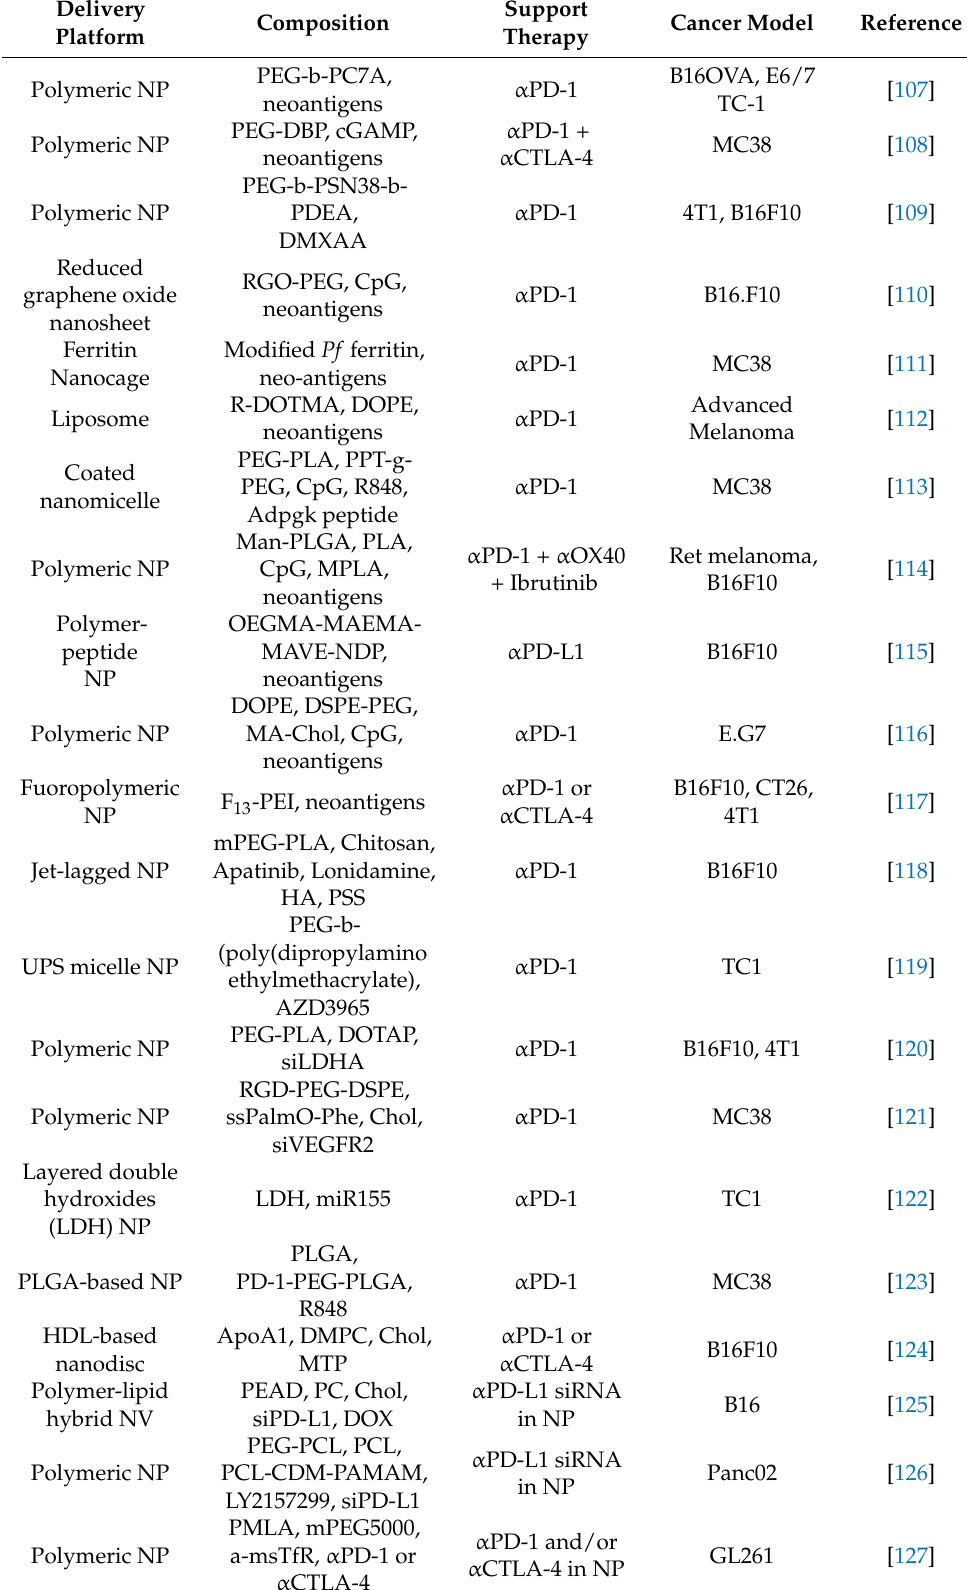
Table 1. NP-based delivery systems designed to improve ICI and ACT